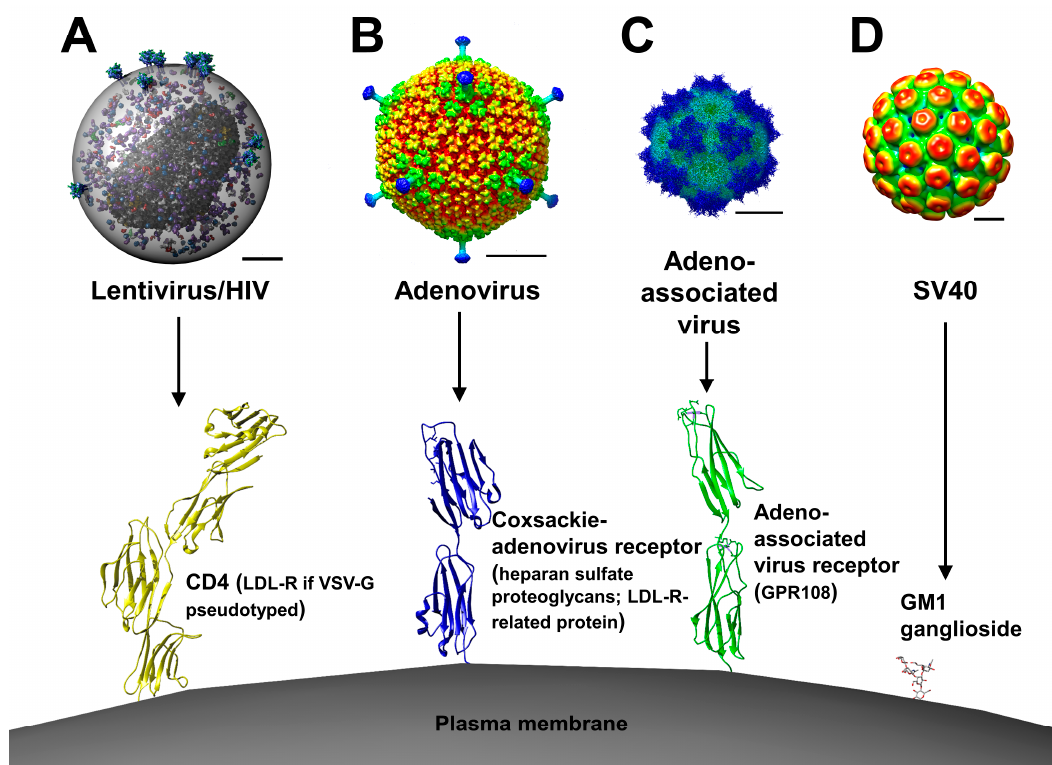
Figure 1. Viral vectors used in liver-targeted gene therapy. ( A ) Lentiviral vectors are able to transduce dividing and non-dividing cells and have their origin in HIV (rendered as cellPACK molecular model) [86]. HIV-based vectors bind to CD4 receptors (PDB ID: 1WIO) [87] as well as to CCR5 or CXCR4 coreceptors, mediating entry into the host cell via a cell–viral membrane fusion mechanism. Several lentiviral vectors are pseudotyped with vesicular stomatitis virus glycoprotein (VSV-G), as well as envelope glycoproteins of other vesiculoviruses, the cognate receptor of which is the low-density lipoprotein receptor (LDL-R) [16,17]. Scale bar = 300 Å. ( B ) Adenoviruses (EMDB ID: EMD-5538) [88] enter cells via attachment to the Coxsackie adenovirus receptor (CAR) (PDB ID: 3JZ7) [89], then attachment to α v β 3/5 integrins. Receptor attachment triggers clathrin-mediated, dynamin-dependent endocytosis, with subsequent endosomal escape, cytosolic transport via microtubules and DNA nuclear import via engagement with the nuclear pore complex (NPC). Adenoviruses can also enter the cell via to heparan sulfate proteoglycans (HSPGs) or the LDL-R-related protein [90]. Scale bar = 300 Å. ( C ) Adeno-associated viruses (EMDB ID: EMD-9012) [91] attach to cells first via HSPGs, with the adeno-associated virus receptor (AAVR) (PDB ID: 6NZ0) [92], subsequently entering the cell